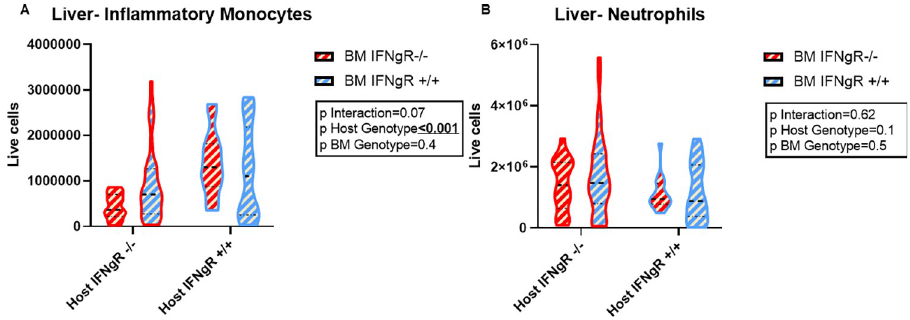
Fig 4. Inflammatory monocyte recruitment is determined by hepatic IFN- γ receptor. Quantitative assessment of myeloid cells (Live, CD90.2-, B220-) by flow cytometry. (A) Inflammatory Monocytes (Ly6G-, CD11b+, Ly6C+) and (B) Neutrophils (Ly6G+,CD11b+) infiltrates in liver (n � 14 mice per group). All data were analyzed for BM and non- hematopoietic IFN- γ -R effects as well as interactions between these compartments using 2-way ANOVA. Blue represents IFNgR+/+ and red IFNgR-/- in BM (zebra filling) and non-hematopoietic (violin plot boarder). P-values for each effect are denoted in box embedded in the graphs; medians and quartiles are depicted in the dashed and dotted lines